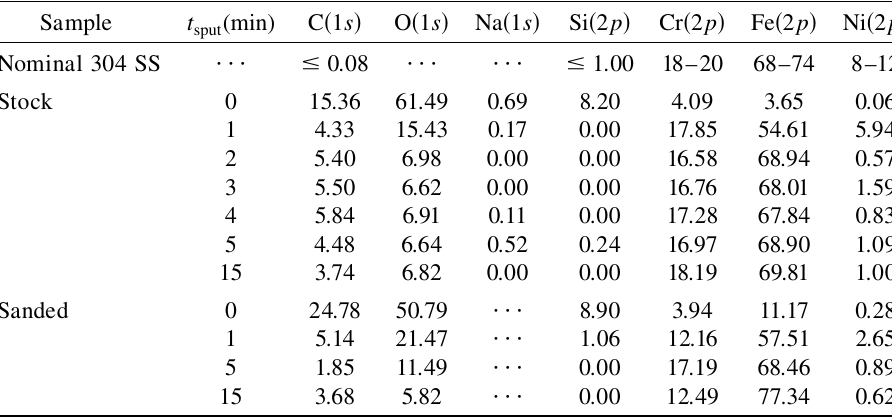
TABLE I. Surface constituents in percent measured with Auger electron energy spectros- copy, from the electron shells listed in parenthesis for each element. The times listed are the cumulative sputtering duration.